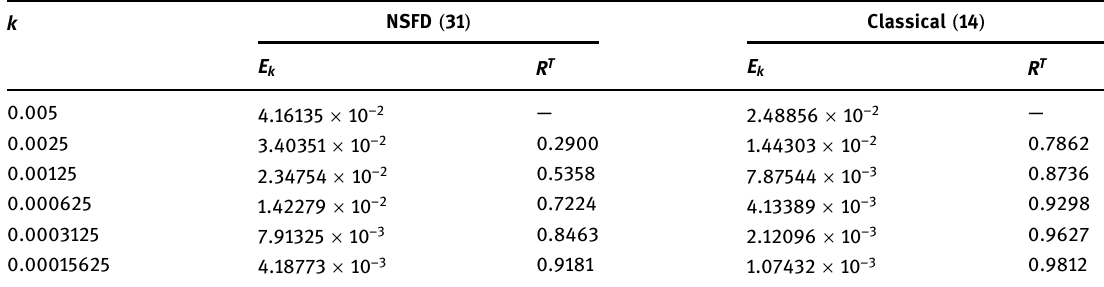
Table 4: Rate of convergence in time using experiment 3 for NSFD and classical for = h 0.02 at time = t 0.01